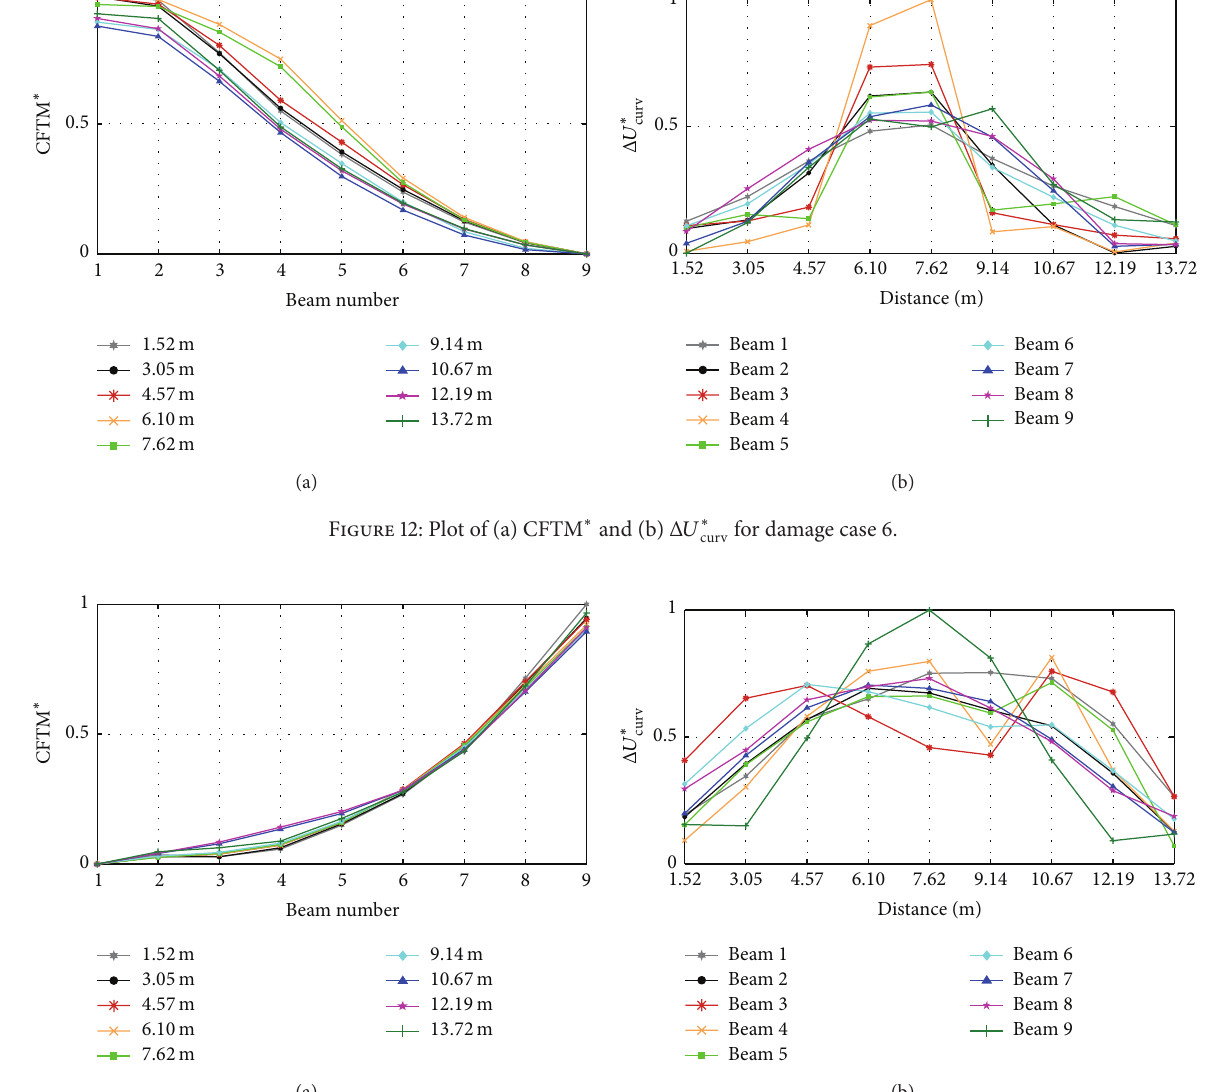
for damage case curv